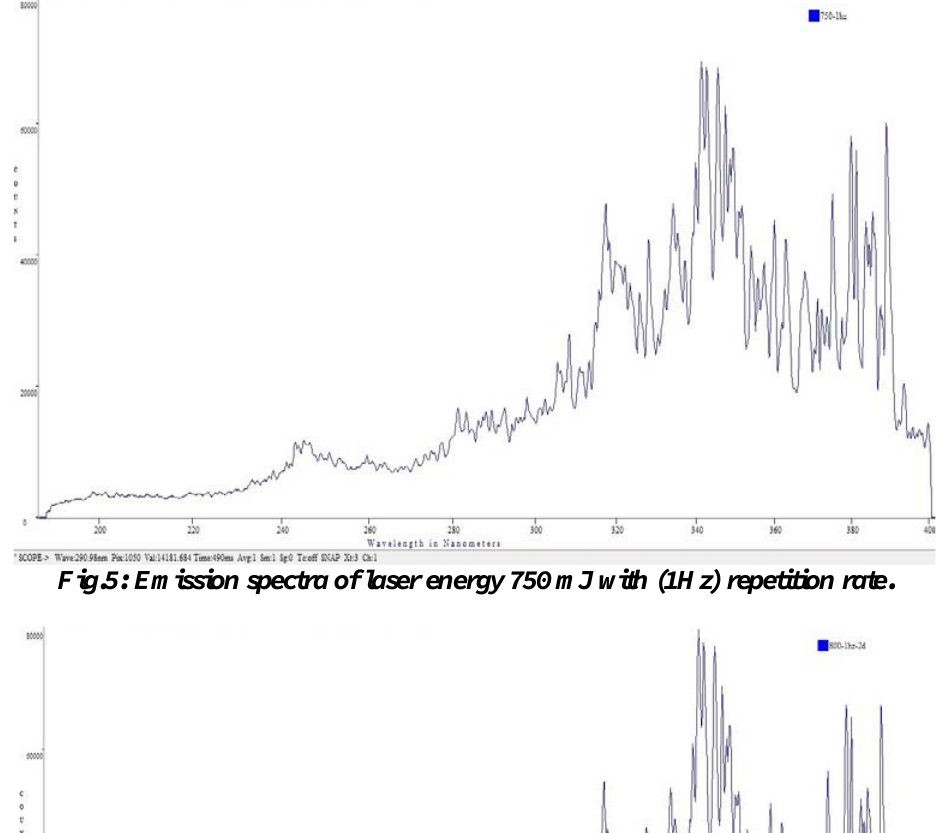
Fig.5: Emission spectra of laser energy 750 mJ with (1Hz) repetition rate.